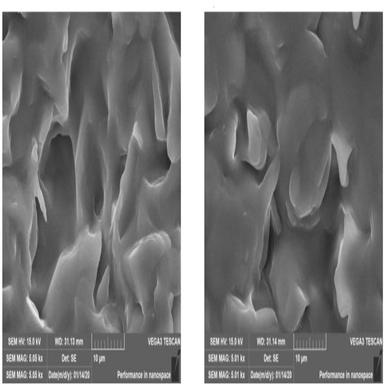
FESEM micrographs of a) PPC2-0.5% before thermal cycle b) PPC2-0.5% after 200 thermal cycles.